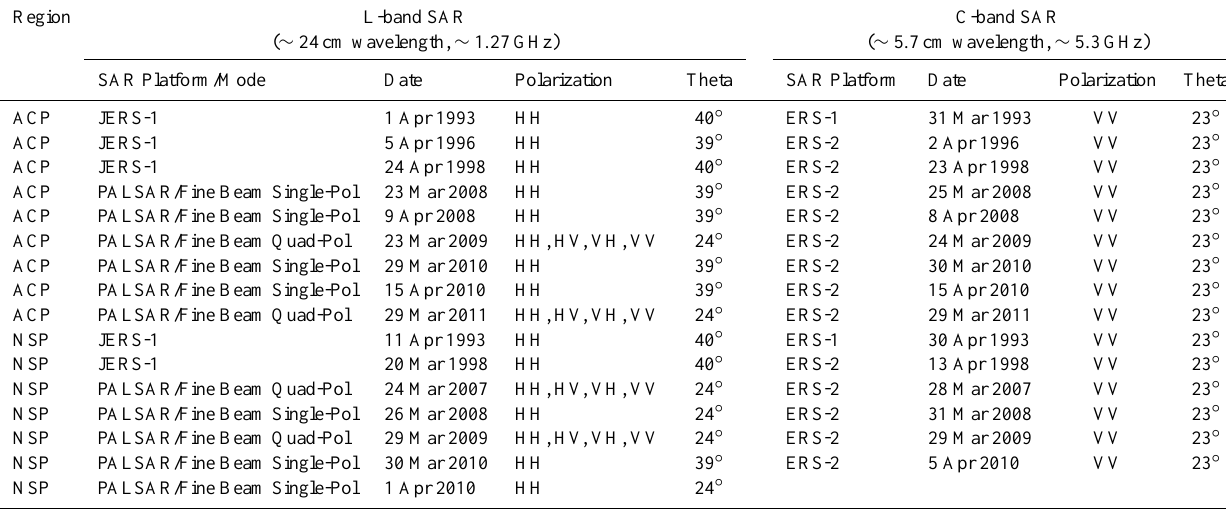
Table 1. SAR data were selected based on data availability over two study areas for late March–April from 1993 through 2011. Region